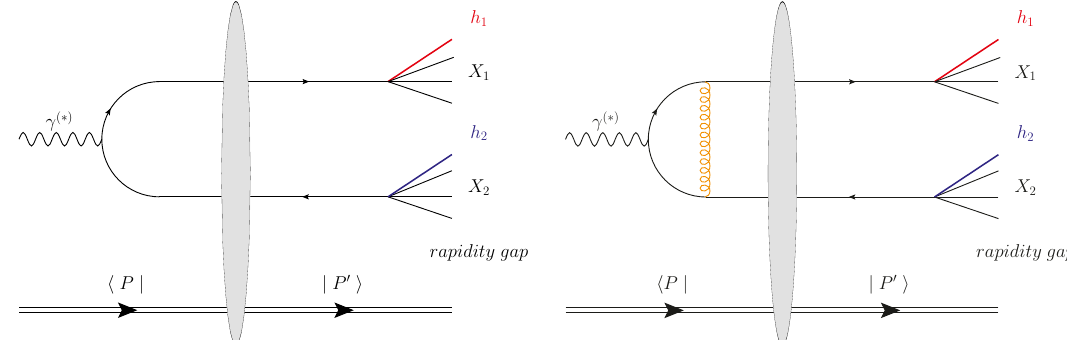
Figure 1 . Left: amplitude of the process (2.1) at LO. Right: an example of amplitude contributing to the process (2.1) at NLO. The grey blob symbolizes the QCD shockwave. The double line symbolizes the target, which remains intact in the figure, but could just as well break. The quark and antiquark fragment into the systems ( h are drawn in red and